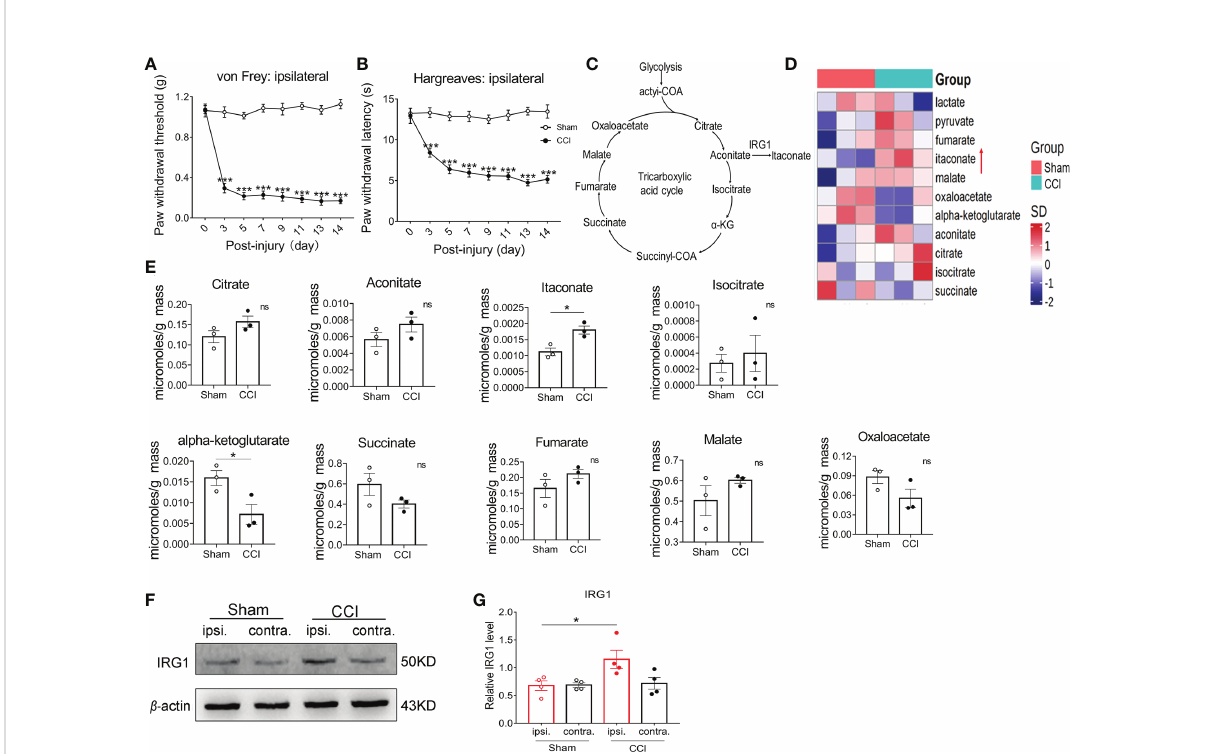
FIGURE 1 The content of itaconate and IRG1 increased in the spinal cord of CCI mice. The CCI model mice exhibited the signi fi cant decrease in the PWT (A) and PWL (B) of ipsilateral hind paw from 3rd day post nerve injury. Data are presented as mean ± SEM. *** p <0.001 vs. Sham, by two-way ANOVA with Tukey ’ s multiple comparisons test (n = 10). (C) Diagram of the tricarboxylic acid (TCA) cycle. (D) The heat map of the mass spectrometry result showed that the content of the TCA cycle intermediates in the L3-L5 segment of the ipsilateral spinal cord from sham and CCI mice at 14th days post nerve injury. (E) The changes in the content of the intermediate products of the TCA cycle. Data are presented as mean ± SEM. * p < 0.05 vs. Sham, by Paired t tests (n = 3). (F) The representative image of western blot for the expression of IRG1 in the L3-L5 segments of ipsilateral and contralateral spinal cord from sham and CCI mice. (G) The level of IRG1 protein in the ipsilateral spinal cord at 14th days after nerve injury signi fi cantly increased. Data are presented as mean ± SEM. * p <0.05 vs. Sham, followed by One-way ANOVA with Dunnett ’ s multiple comparisons test (n = 4). ns, no signi fi